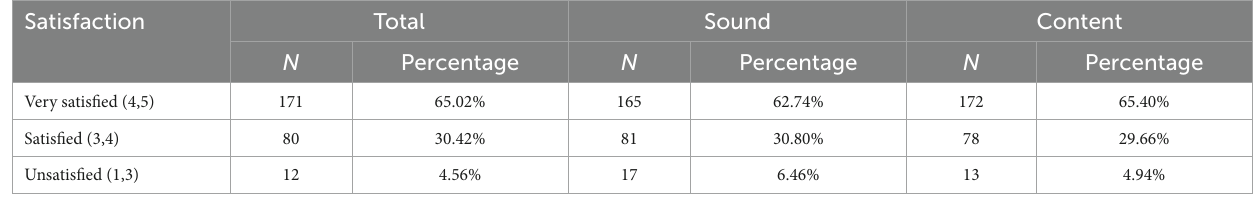
TABLE 6 Statistics of students’ total satisfaction ( N = 263).